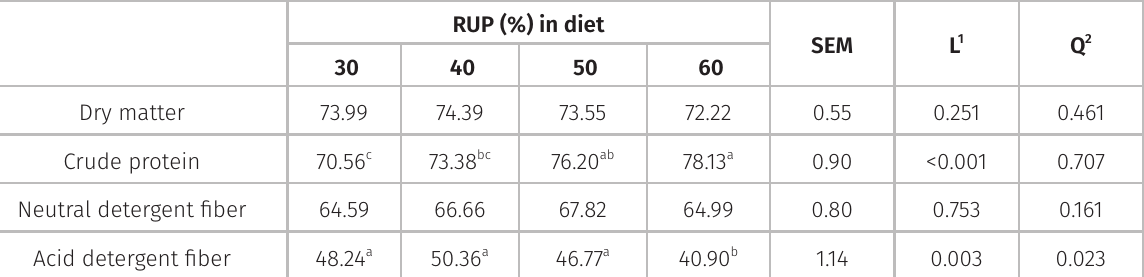
Table III. Nutrient digestibility (%) of cross bred (Friesian×Jersey) dairy cattle fed diets with various levels of rumen undegradable protein